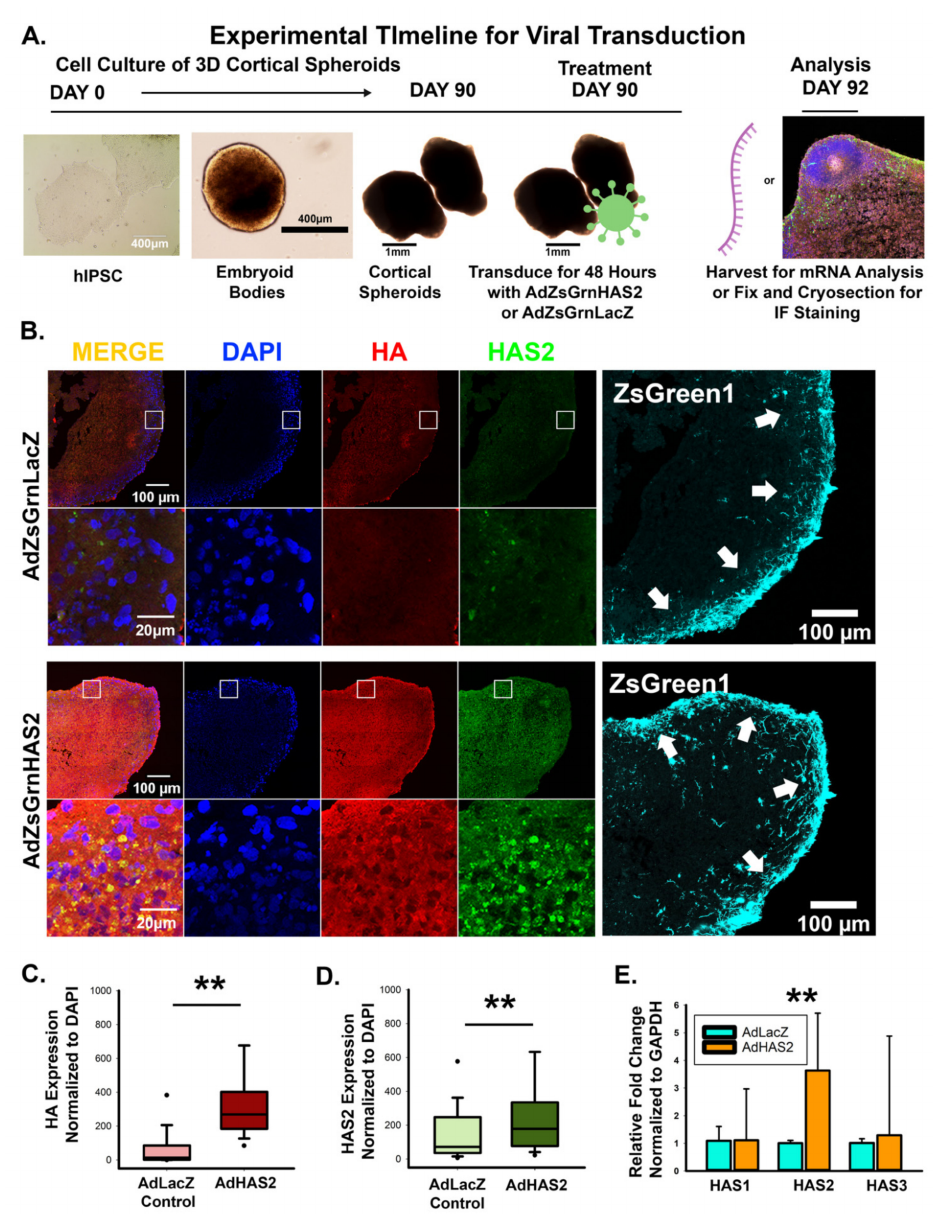
Figure 3. ( A ) Workflow for viral transduction of 3D cortical spheroids for manipulation of HAS2. ( B ) Representative images of cortical spheroids virally transduced to express HAS2. Top panel: adenoviral expression of ZsGreen and LacZ control (AdZsGreenLacZ). Bottom panel: adenoviral expression of ZsGreen and HAS2 (AdZsGreenHAS2), stained for DAPI (blue), HA (red), and HAS2 (green). The highlighted region of the cortical plate is enlarged below. To the right is the viral co- expression of the fluorophore, ZsGreen1. Arrows indicate the cortical plate, where synaptic analysis was performed. Scale bars top: 100 µ m, enlarged region: 20 µ m. ( C ) Quantified HA expression (via HABP) normalized to DAPI. n = 9 total spheroids for each AdZsGrnLacZ and AdZsGrnHAS2 derived from 3 separately grown and transduced spheroid sets ** p < 0.001. ( D ) Quantification of HAS2 expression normalized to DAPI. n = 9 total spheroids for each transduction (AdZsGrnLacZ and AdZsGrnHAS2). Spheroids were derived from 3 separately grown and transduced spheroid sets ** p < 0.001. ( E ) qRT-PCR confirmation of increased HAS2 expression. n = 20 total spheroids derived from 4 separately grown and transduced spheroid sets. ** p <